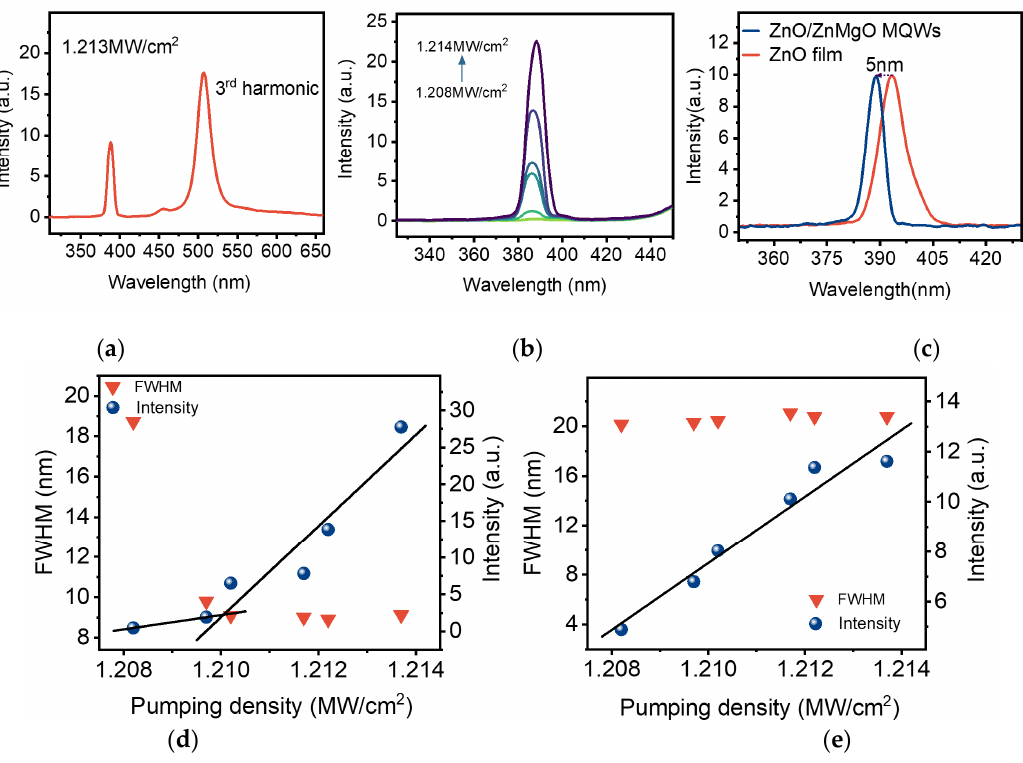
Figure 4. Analysis of MPA upconversion optical characteristics. ( a ) A typical complete PL spectrum includes the dominant emission peak and the third harmonic peak from the MQWs at room temperature. ( b ) The spectrum of dominant emission peaks in the MQWs under different excitation power. ( c ) The upconversion PL lasing spectra of the ZnO films and ZnO/ZnMgO MQWs at RT. ( d ) The experimental data of dominant emission peak in MQWs for the integrated emission intensity and FWHM versus the excitation power show a “kink”. ( e ) The integrated emission intensity and FWHM of the third harmonic peak in MQWs versus pumping power.